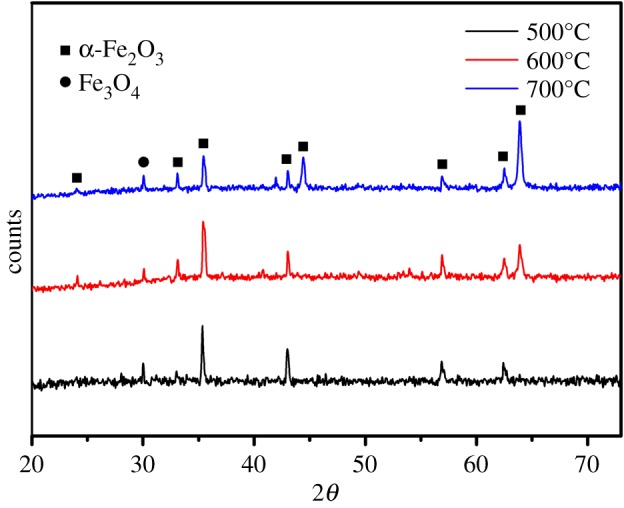
XRD patterns of the Fe2O3 nanowire arrays at different temperatures from the polished samples.